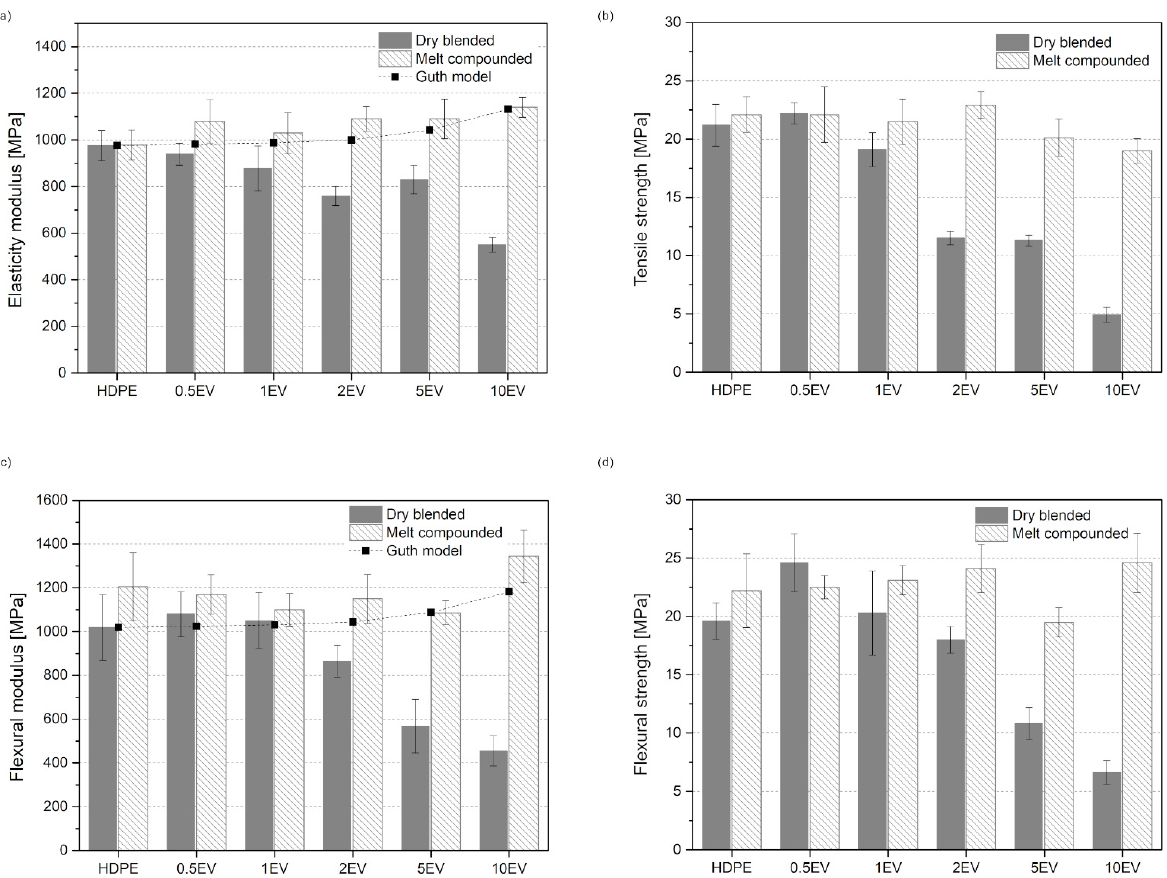
Figure 8. Mechanical properties of composite samples from the tensile test: elasticity modulus ( a ) and tensile strength ( b ), and from flexural bending: flexural modulus ( c ) and flexural strength ( d ). The impact strength for notched samples does not show such significant differences between dry blended and melt compounded samples (Figure 9a). Impact strength for all samples decreases with the increasing amount of expanded vermiculite. The dry blended series shows slightly lower impact strength except for sample 2EV. Another way to meas- ure the material’s strength is to calculate the toughness from the tensile test [33]. The cal- culated toughness values are expressed in the column graph in Figure 9b. This value dras- tically decreases for dry blended samples when the amount of filler increases to 1 wt% EV. This means that the energy needed to break the specimen in an uniaxial tensile test decreases. For melt compounded parts, the toughness goes slightly higher for 1EV and 2EV; then, this value decreases with the increasing amount of filler. Differences among samples dry blended and melt compounded are seen in neat samples and containing 0.5% EV. Their toughness is a bit higher for dry blended samples, but with the growth of the filler amount, the toughness for melt compounded samples increases. These two methods of determining the toughness show the same tendency: the decrease in toughness value with the increasing amount of the filler. All performed mechanical test proves the hypoth- esis that dry blended rotomolded composites reveal significantly lower mechanical strength.